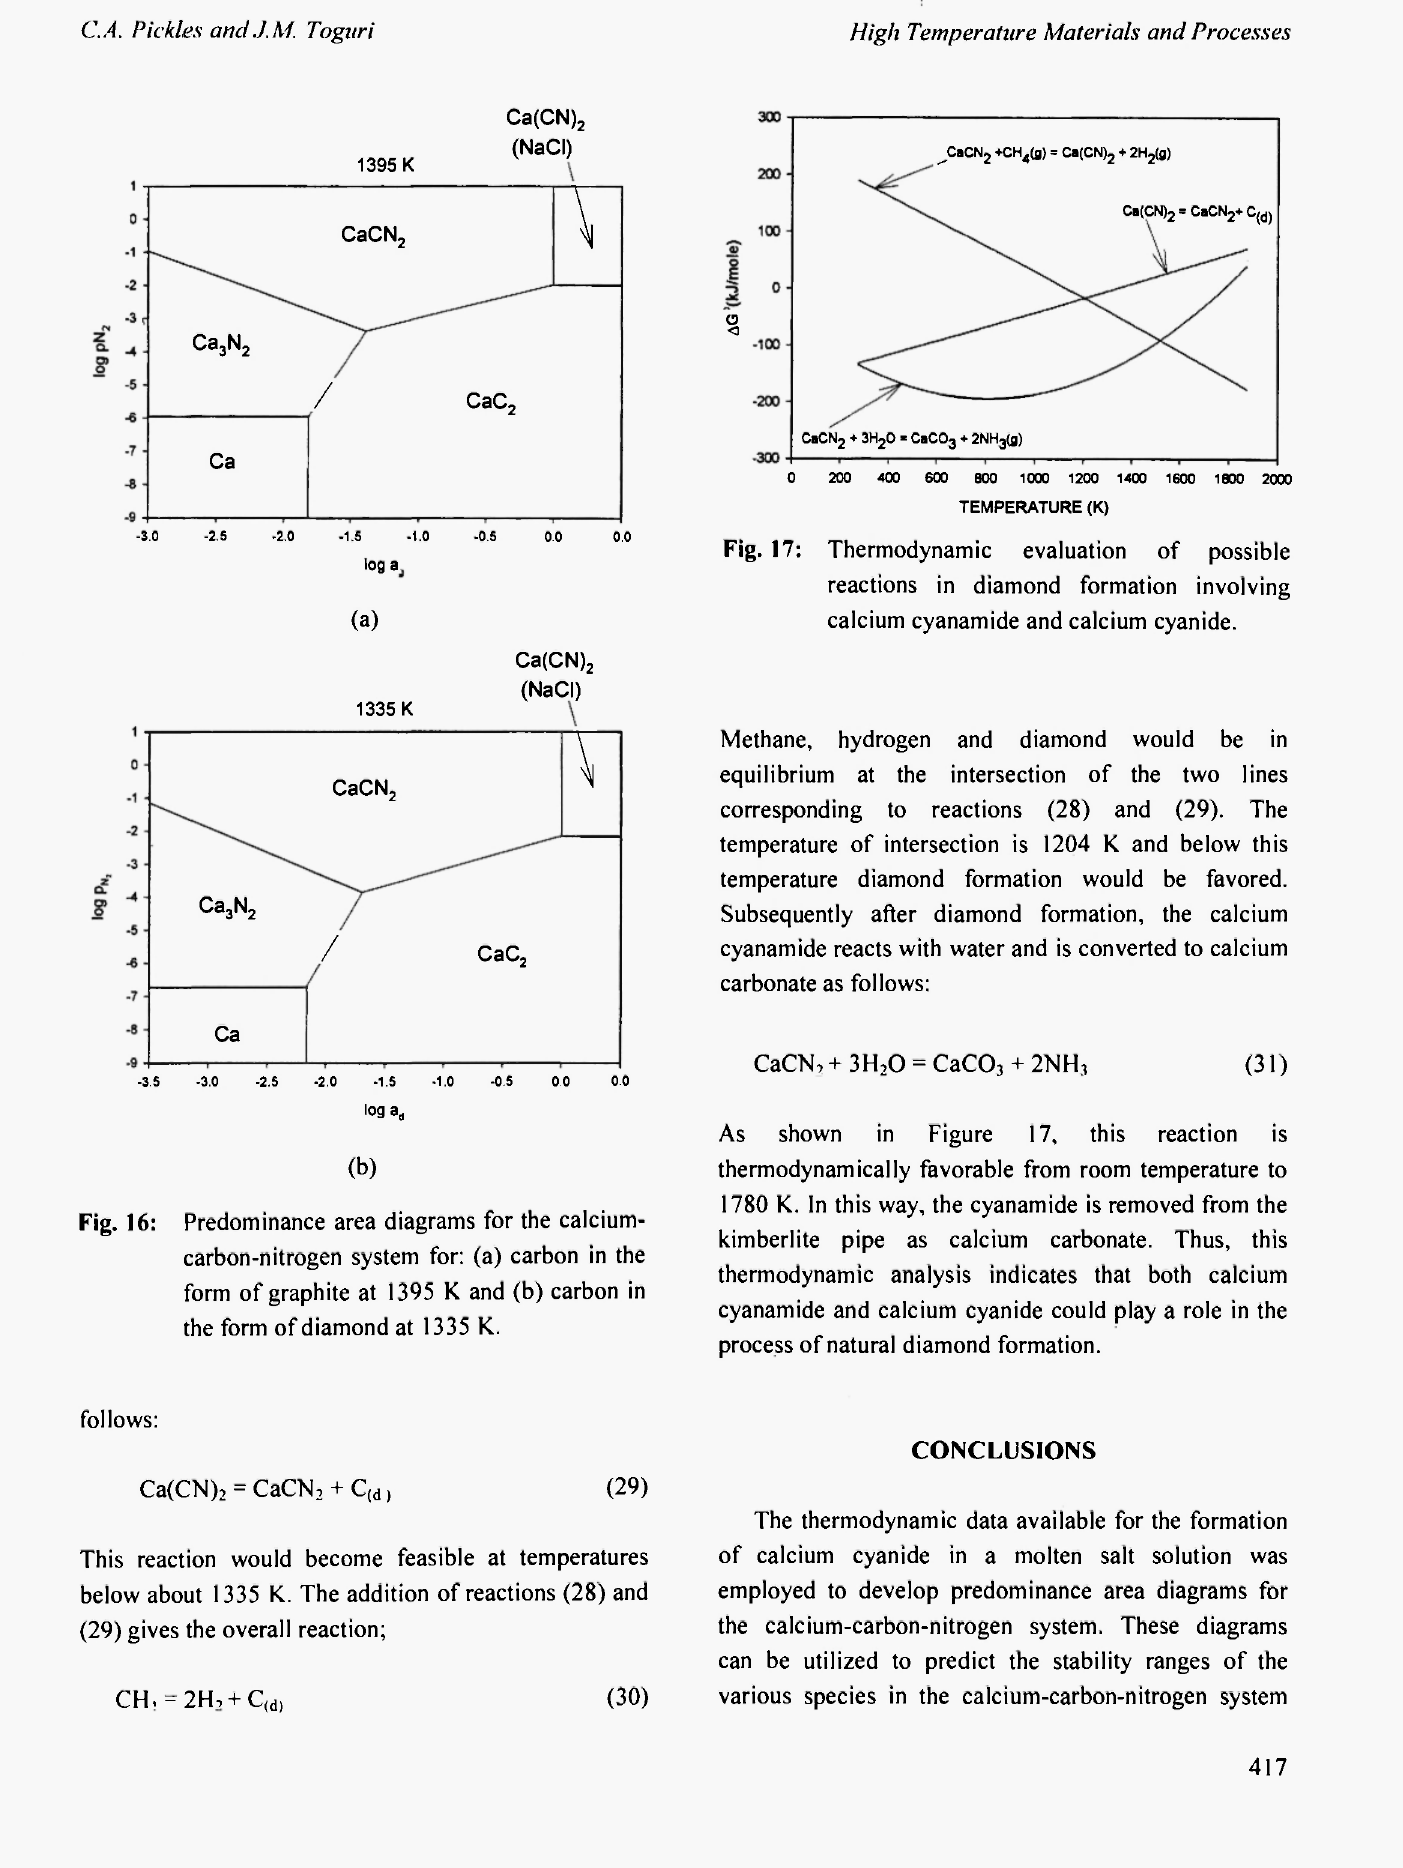
Fig. 17: Thermodynamic evaluation of possible reactions in diamond formation involving calcium cyanamide and calcium